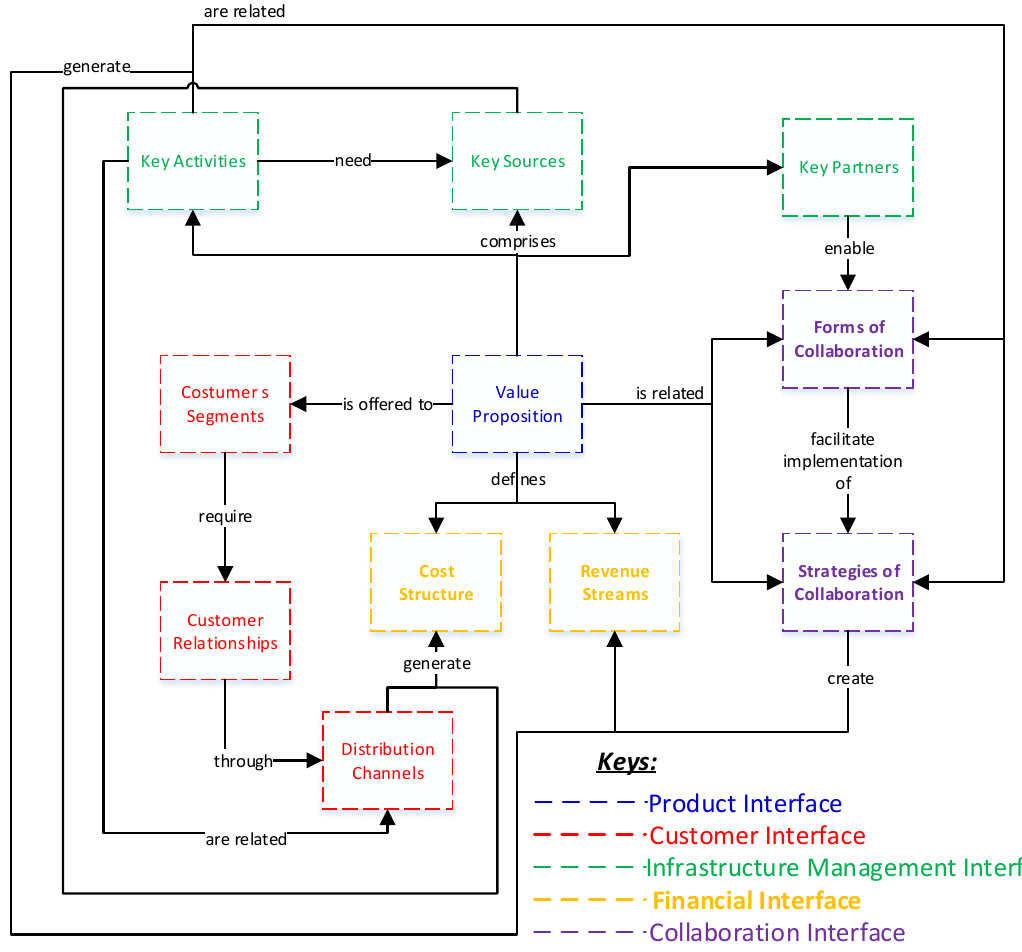
Figure 5. Relationship among building blocks of the FCBM.